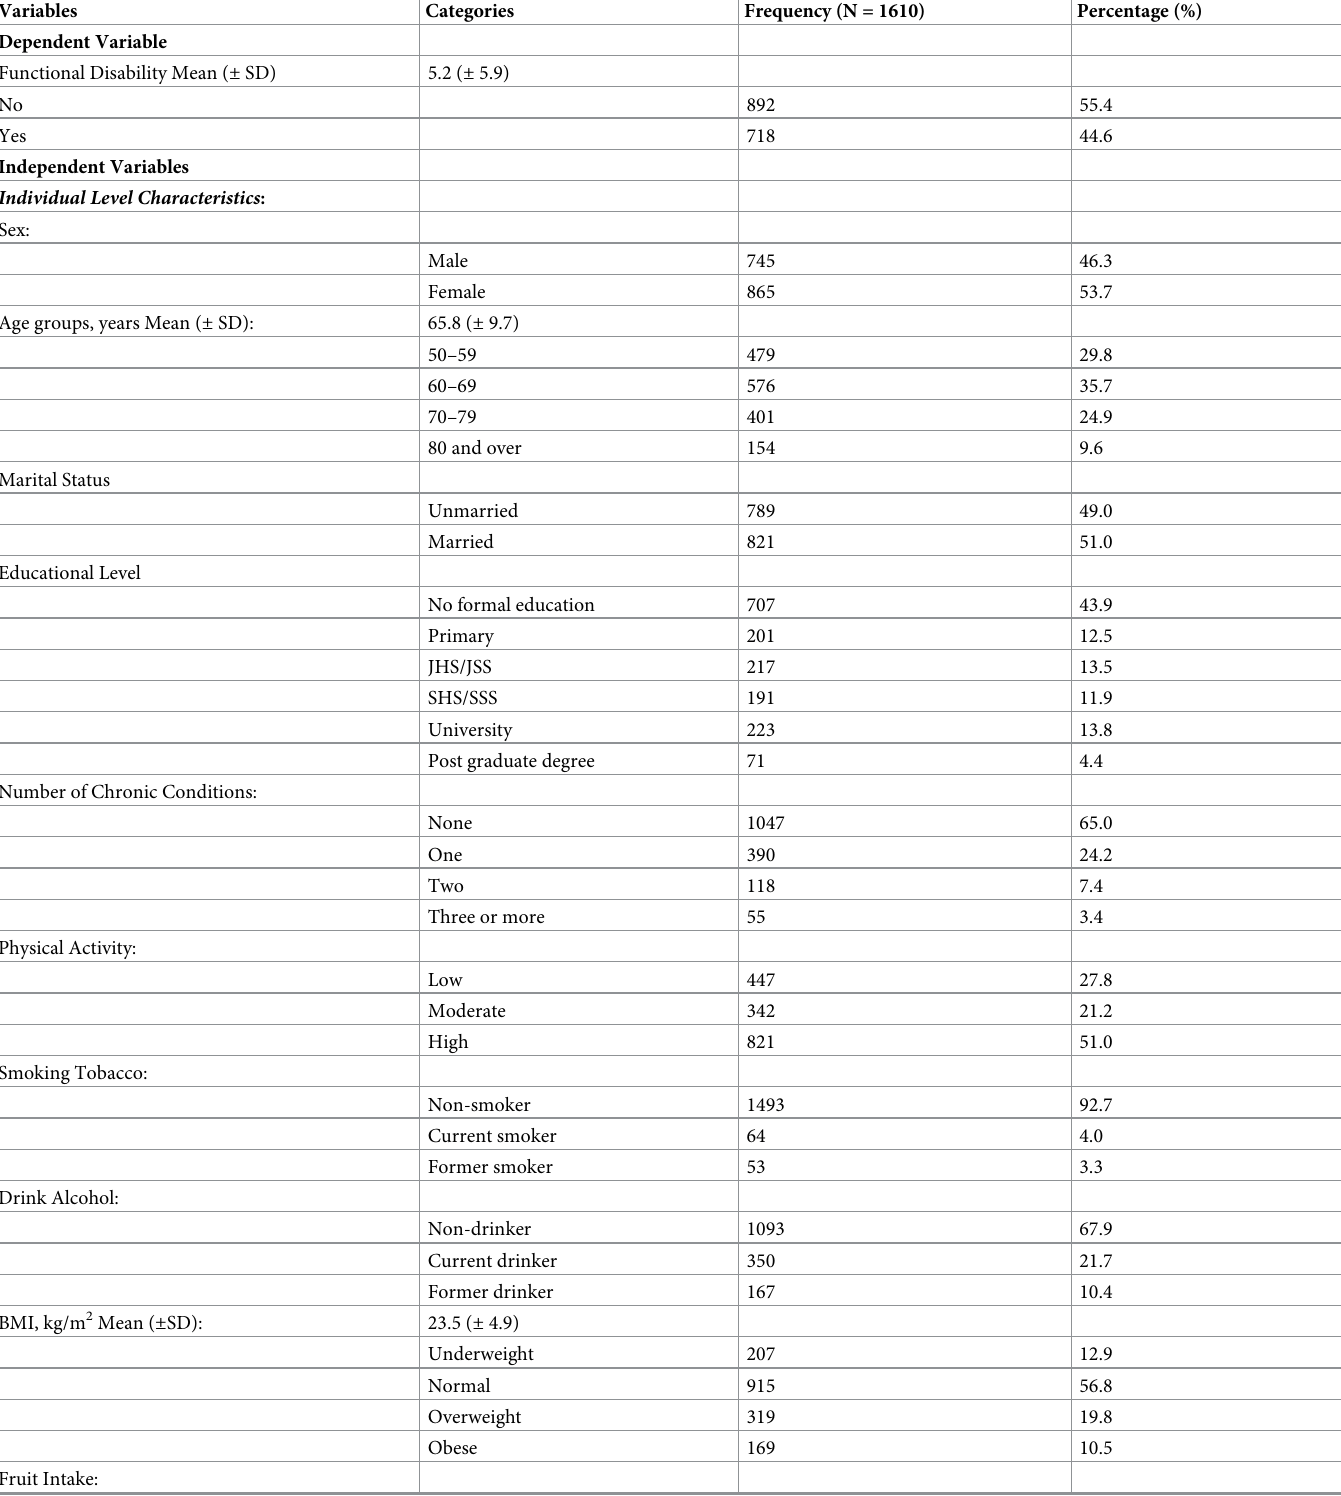
Table 1. Descriptive statistics of individual and household-level characteristics of study